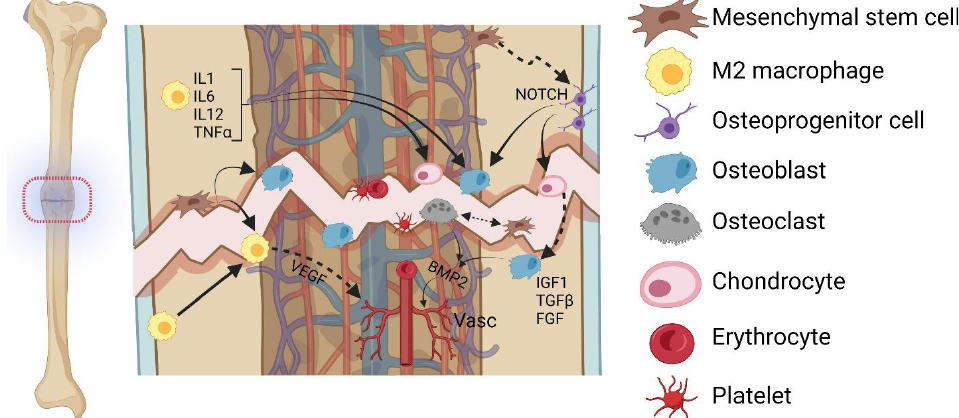
Figure 2. Cellular components contributing to (impaired) bone healing . The initial fracture gap is filled quickly by a hematoma, followed by the immigration of mesenchymal stem cells originating from the underlying periosteal layer [32]. These differentiate into osteoprogenitor cells (crucial neu- rogenic locus notch homolog protein 1 [NOTCH] signaling) [33], further giving rise to cells that clear the fracture site (osteoclasts) and form a fibrocartilaginous callus (chondrocytes, osteoblasts) before the inferior cartilage is transformed into ossified bone. Osteoblastic insulin-like growth factor 1 (IGF1), transforming growth factor β (TGF - β) , and fibroblast growth factor (FGF) are decisive for bone union [34]. M2 macrophages orchestrate the healing process via interleukin-1 (IL1), IL6, IL12, and tumor necrosis factor α (TNF - α) [11]. The newly developing vasculature is stimulated by vas- cular endothelial growth factor (VEGF) and bone morphogenetic protein 2 (BMP2) [35], and eryth- rocytes as well as platelets form the initial clot in which the callus is formed. Created with BioRen-